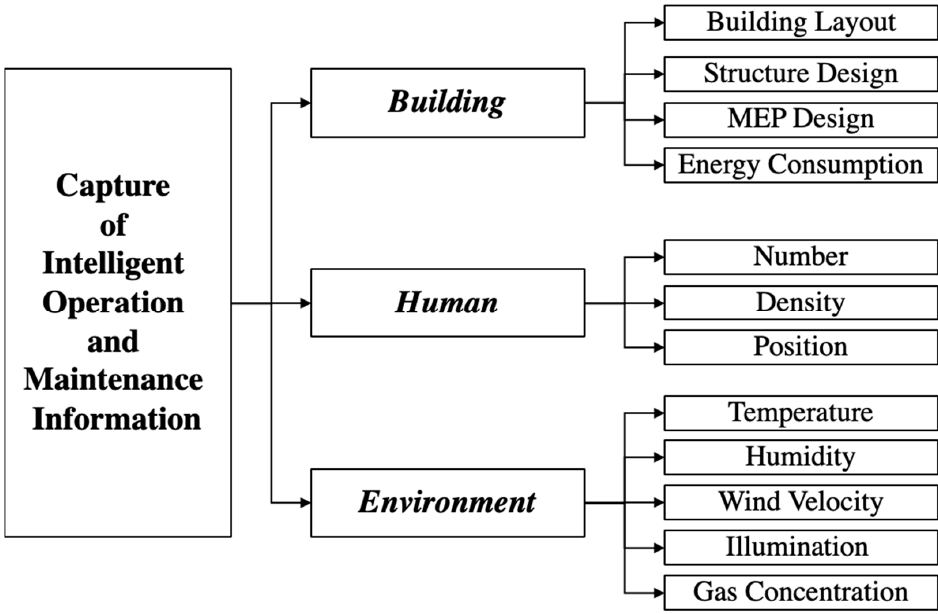
Figure 1. Intelligent O&M information capture system.